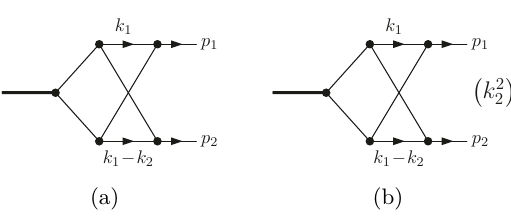
Figure 4 . Two-loop non-planar triangles that admit a d log form. The factor ( k 2 integrand (b) corresponds to an irreducible scalar product in the